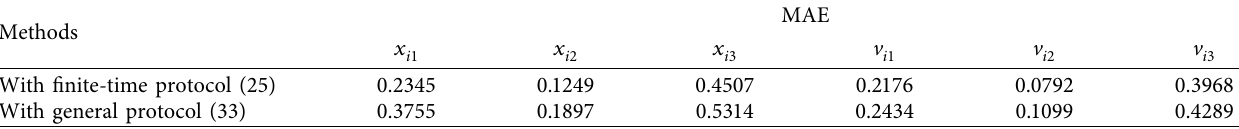
Table 2: The mean absolute error of the two